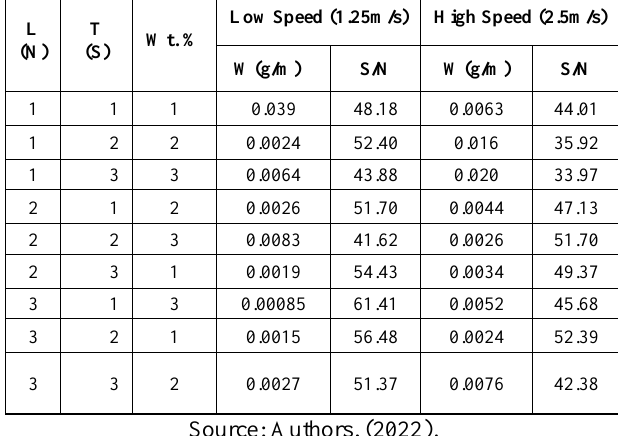
Table 5: Results of the wear rate and S/N ratios.